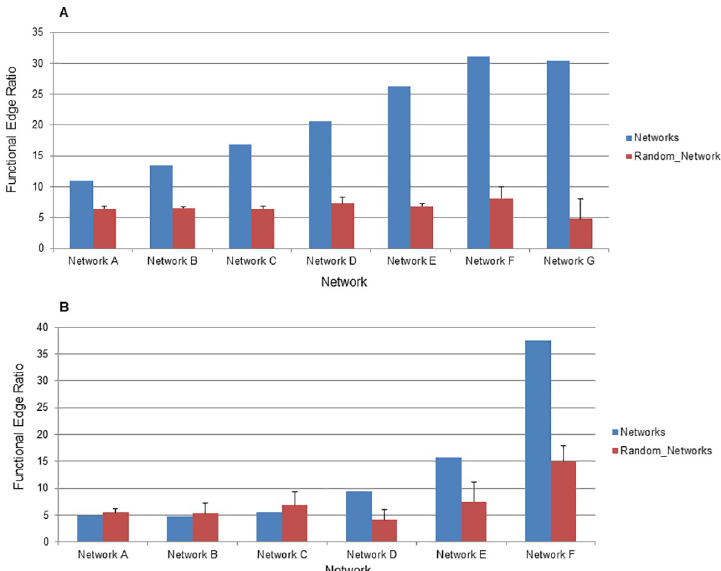
Fig 5. Quality of GENIE3 across increasing edge cutoffs. (A) The ratio of Transcript-Transcript edges (as a percentage) connecting annotated features in the same functional category to all edges connecting annotated features is displayed on the y-axis. The network is displayed on the x-axis. Blue bars represent ratios of edges in the networks described here and red bars represent ratios of edges in randomized networks. Error bars indicate standard deviation of ratios from three randomized networks. (B) The same ratio is shown for Cross-type edges